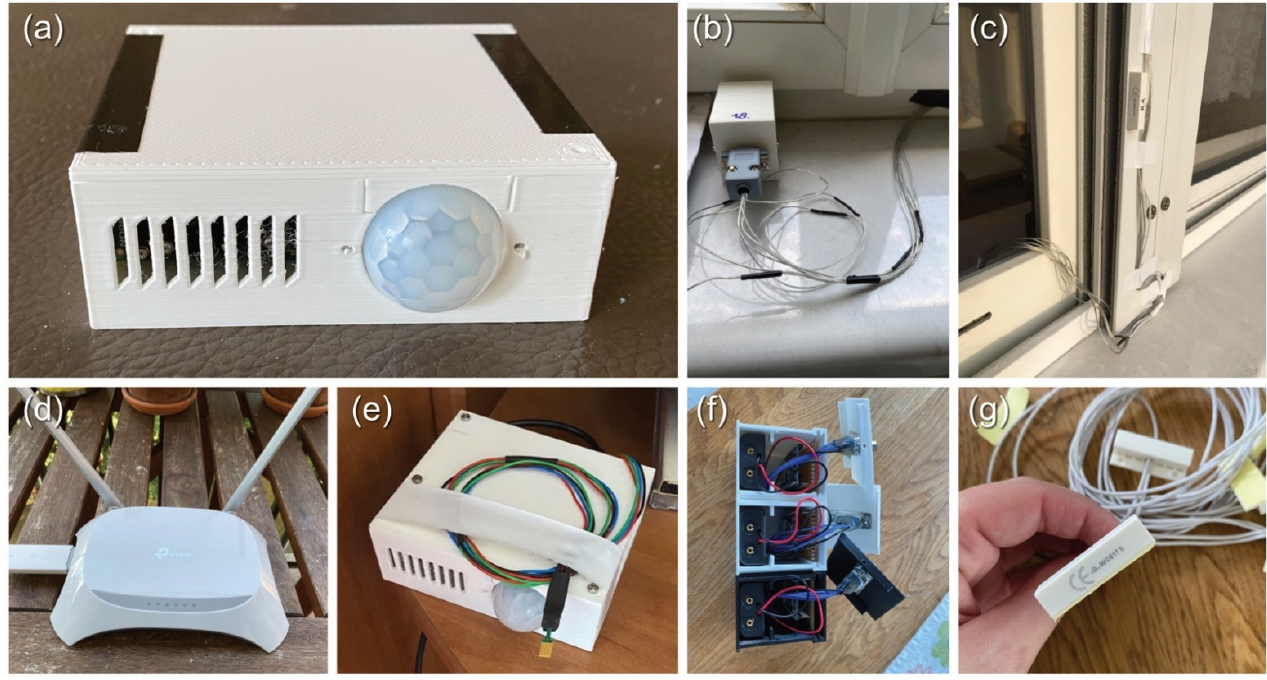
Figure 8. Monitoring system installation: ( a ) room module, ( b , c ) window sensors, ( d ) Wi-Fi module, ( e ) room module, ( f ) window module box and internal parts, ( g ) window and shutter magnetic reed switches.